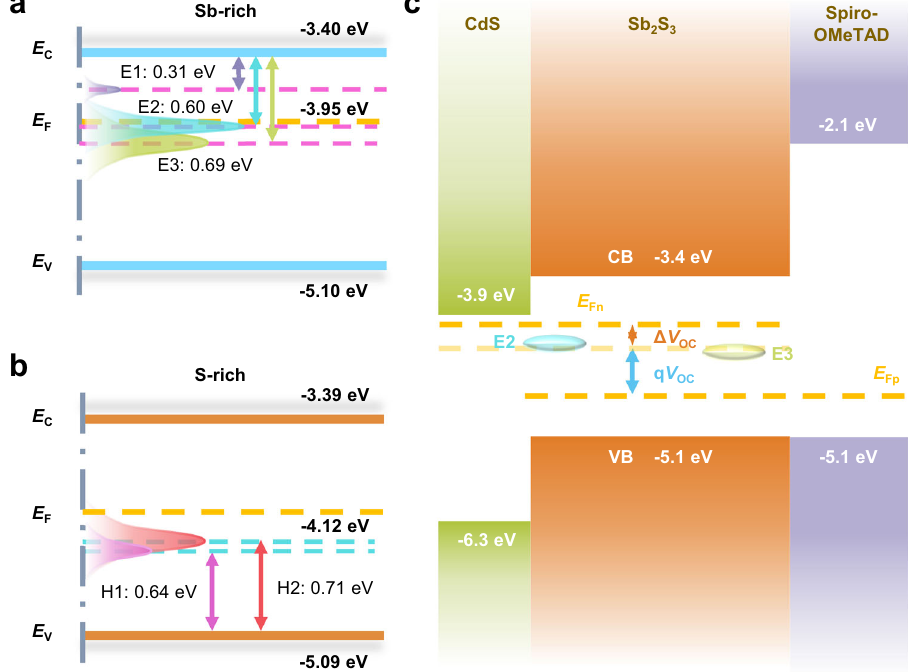
Fig. 5 Schematic of band structure and heterojunction. a , b Conduction band ( E C ), valence band ( E V ), Fermi level ( E F ), and trap energy level ( E T ) for Sb-rich and S-rich Sb 2 S 3 fi lms. c Schematic diagram of V OC derived from split of electron and hole quasi Fermi level ( E Fn and E Fp